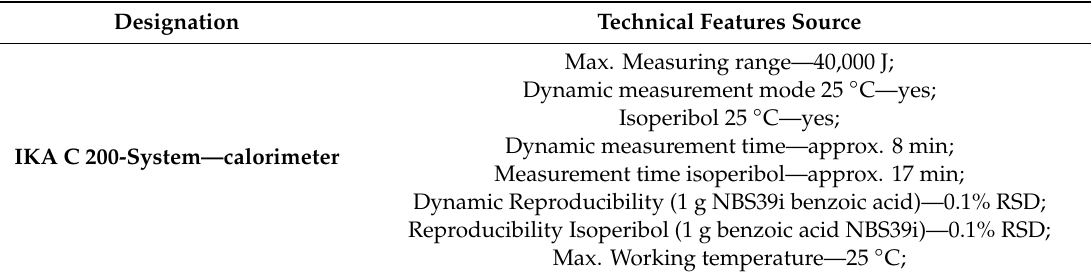
Table 4. Technical characteristics of IKA C 200—calorimeter